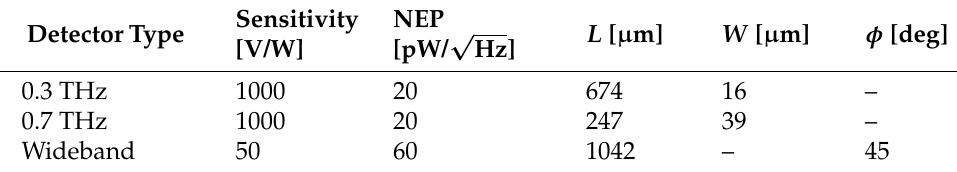
Figure 1. The design and response spectra of antenna-coupled Ti- µ bolometers. Top panel ( a ): The design and schematic cross-section of the Ti- µ bolometer coupled with different antennas for 0.3 THz, 0.7 THz and for wideband detection (from left to right). Digital photos show top views of Ti- µ bolometer detectors coupled with dipole antenna design. The geometry of the titanium bridge amounts to 12 µ m length and 2 µ m width. The angles θ and φ in photo of the wideband detector are defined as sample rotation angle for polarization measurements and the polar angle of antenna fingers, respectively. The design is adapted from Refs. [22,23]. Panel ( b ): Simulated spectra of the normalized antenna gain for the different antenna’s designs. Panel ( c ): Response spectra of the devices were measured using Fourier transform far-infrared spectrometer as described in Ref. [22]. Table 1. The main performance and antenna geometrical parameters of the resonant (0.3 THz and 0.7 THz) and the wideband detectors. Note the same NEP for both resonant antenna-coupled devices. Presented sensitivity values are of Ti- µ bolometer itself, without